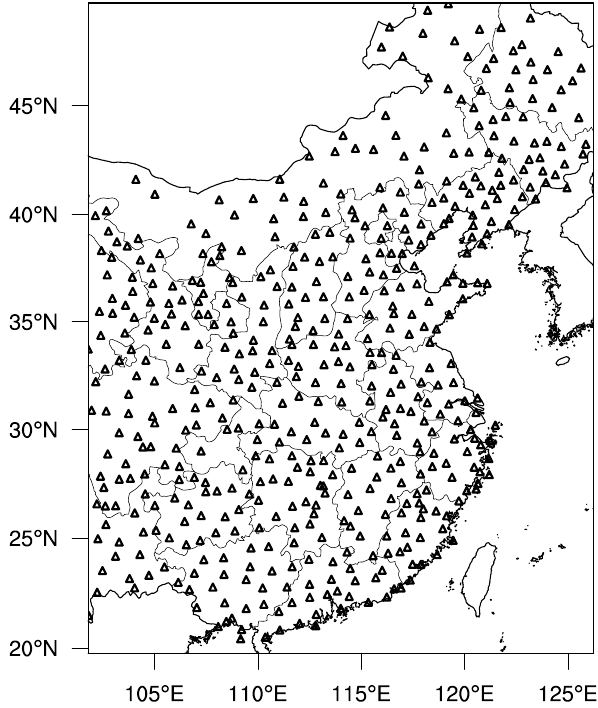
Figure 1. WRF-Chem modeling domain with grid resolution of 27km. The domain covers eastern parts of China. The triangles in- dicate the location of 523 meteorology stations used for evaluations in this